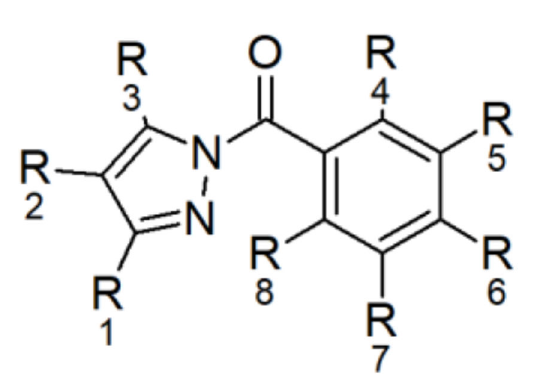
Figure 13. General chemical structure of N